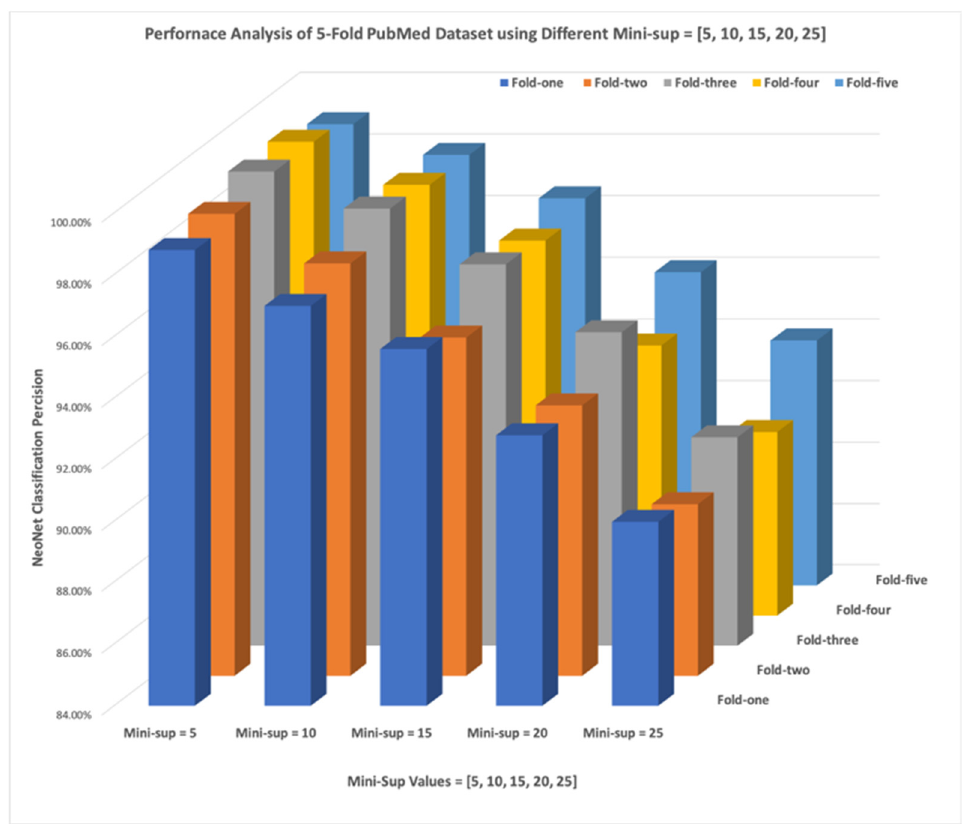
Figure 7. Shows the NeoNet precision with different configurations of the min-sup parameter while classifying a PubMed Coronavirus Dataset. The figure shows five different configurations of the min-sup [5, 10, 15, 20, 25]. The plots are displayed from left to right respective to the values of the configurations.